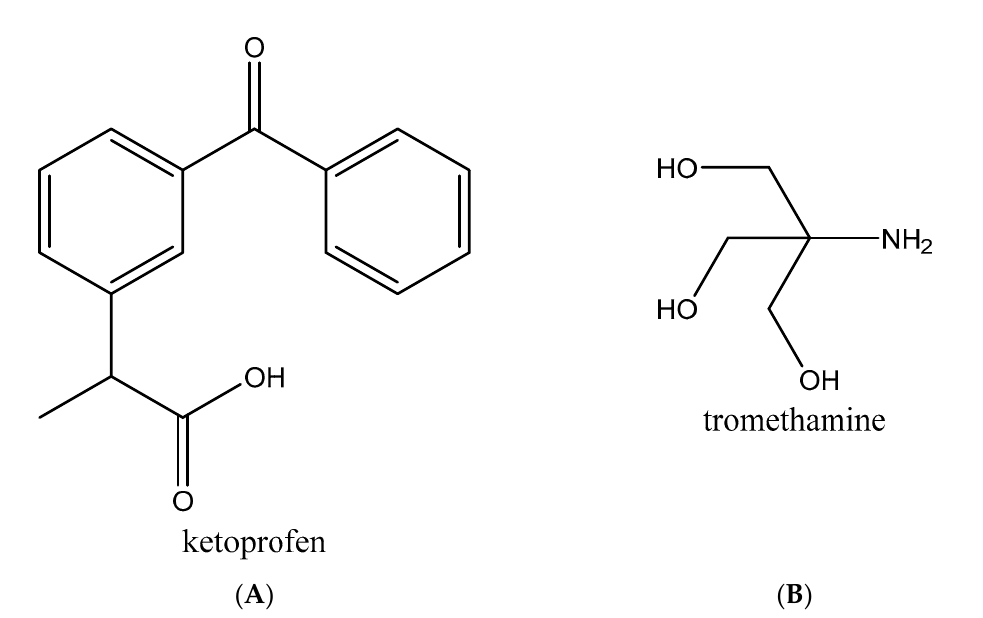
Figure 1. Chemical structures of ( A ) ketoprofen and ( B ) tromethamine.